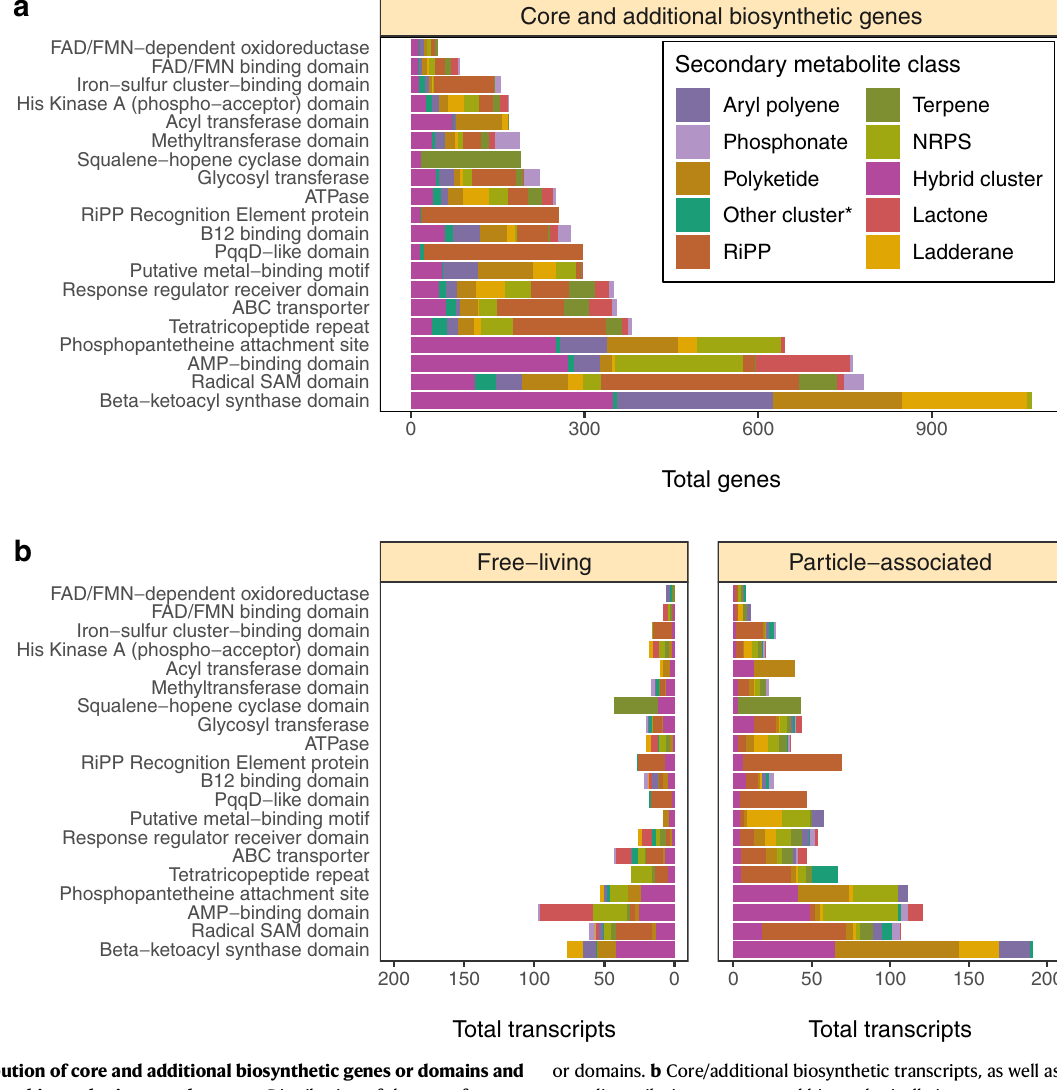
Fig. 4 | Distribution of core and additional biosynthetic genes or domains and transcripts from biosynthetic gene clusters. a Distribution of the most fre- quently detected core/additional biosynthetic genes, genes encoding tailoring enzymes, and biosynthetically important protein domains in clusters ≥ 10kb in length. The “ Core and additionalbiosyntheticgenes ” strip titleof a refersto genes